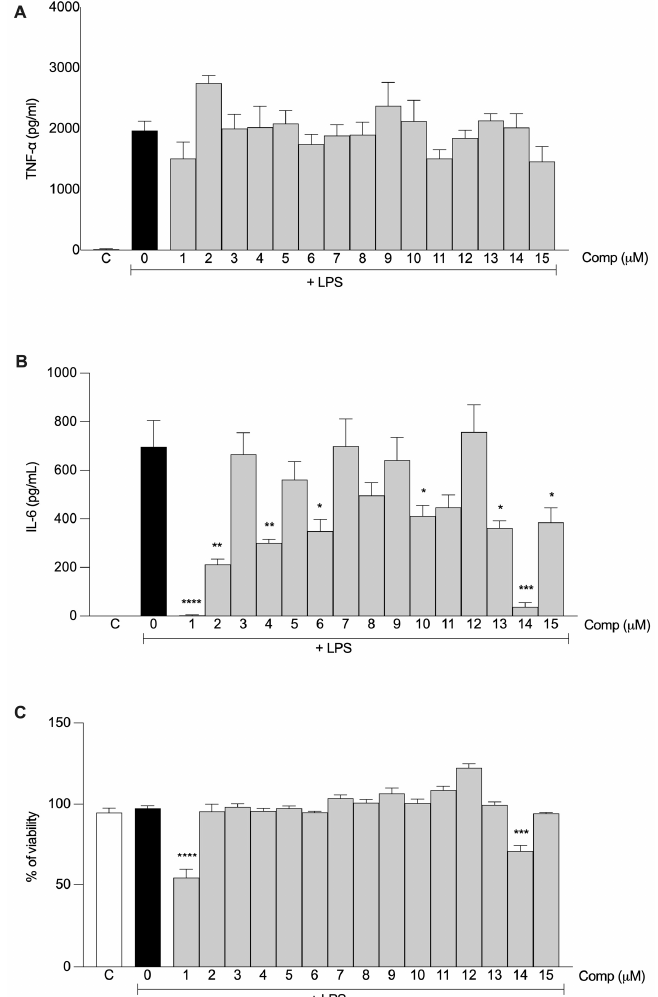
Figure 3. Anti-inflammatory activity of the curcumin derivatives. Peritoneal macrophages from C57BL/6 mice were pretreated with 30 µ M of each compound 1 h before stimulation with 10 ng/mL LPS. After 6 h, the concentration of TNF- α ( A ) and IL-6 ( B ) in the supernatant of the cells was determined. ( C ) Cell viability was tested by MTT assays after supernatant collection. All results are presented as the mean ± S.E.M. from two independent experiments performed in triplicate. *, p < 0.05; **, p < 0.01; ***, p < 0.001; ****, p < 0.0001 relative to LPS stimulus alone (black bar). C, negative control.